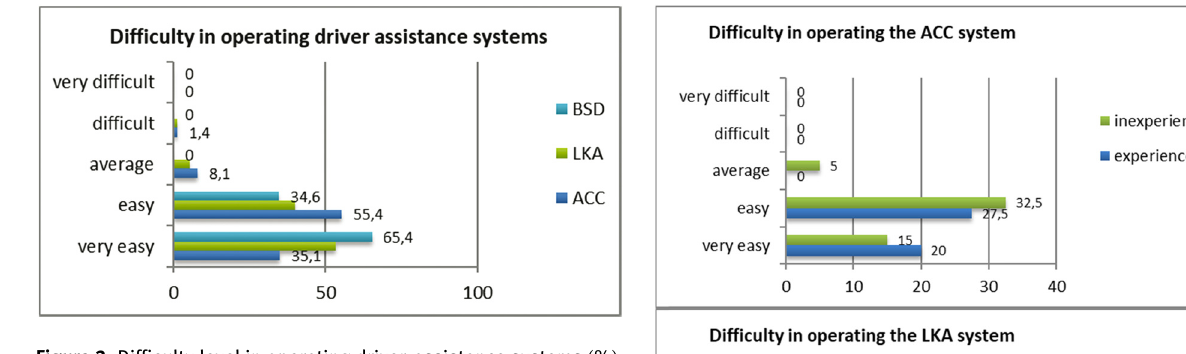
Figure 2: Di ffi culty level in operating driver - assistance systems ( % ) . Source: author ’ s own study.